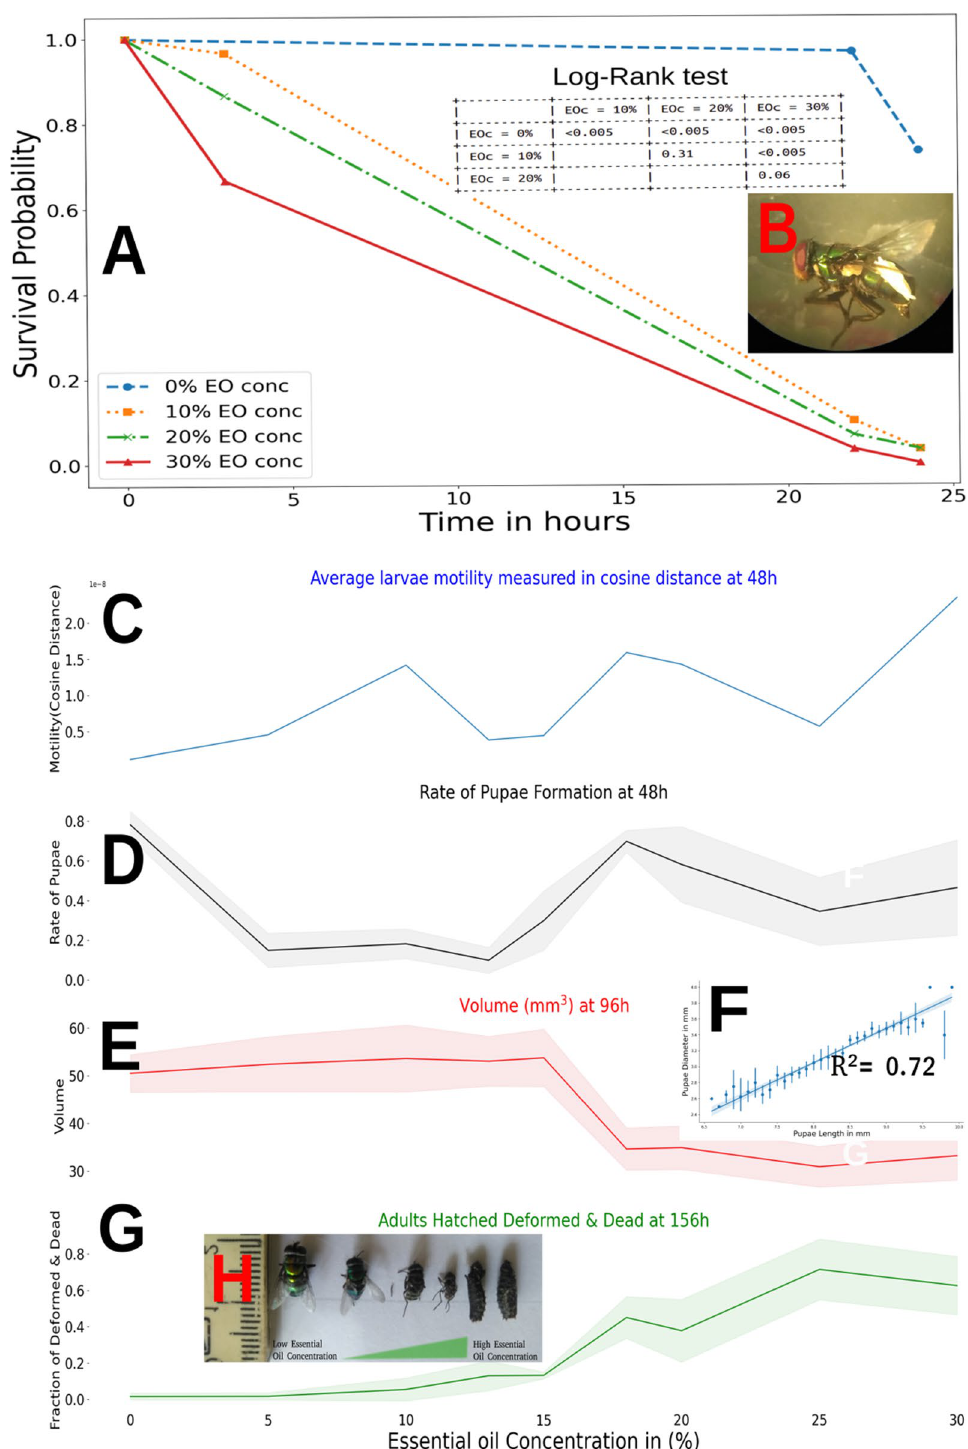
Figure 6. Fumigant activity bioassay showing: ( A ) Kaplan–Meier survival curves and probability log-rank test; ( B ) oviposition by blowflies submitted EO after 22 h of bioassay; ( C ) larval motility measured in Cosine distance over different EO concentration applied; ( D ) pupae rate formation after 48 h after bioassay start; ( E ) pupae volume at 96 h bioassay; ( F ) regression among pupae length and diameter; ( G ) fraction of adults hatched deformed and dead at 156 h of bioassay; ( H ) deformed adults